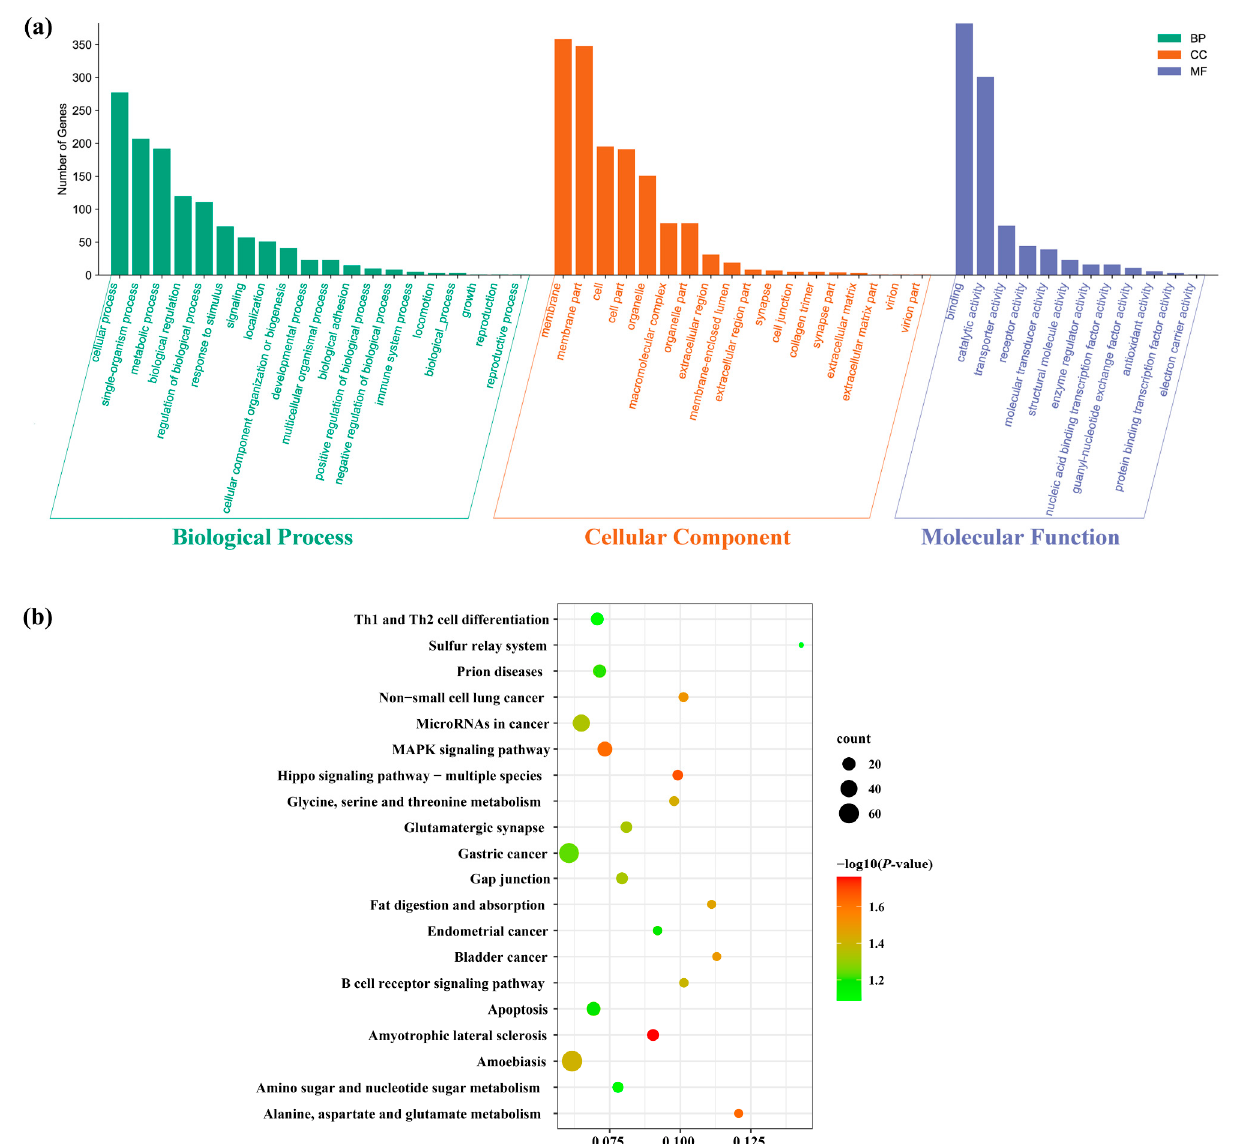
Figure 5. Functional analysis of the predicted target genes of DEMs. ( a ) Gene Ontology classification. X-axis, 50 subcategories. Y-axis, number of genes in a specific functional cluster. ( b ) The top 20 KEGG enrichment pathways. X-axis, enrichment score. Y-axis, KEGG pathway terms.